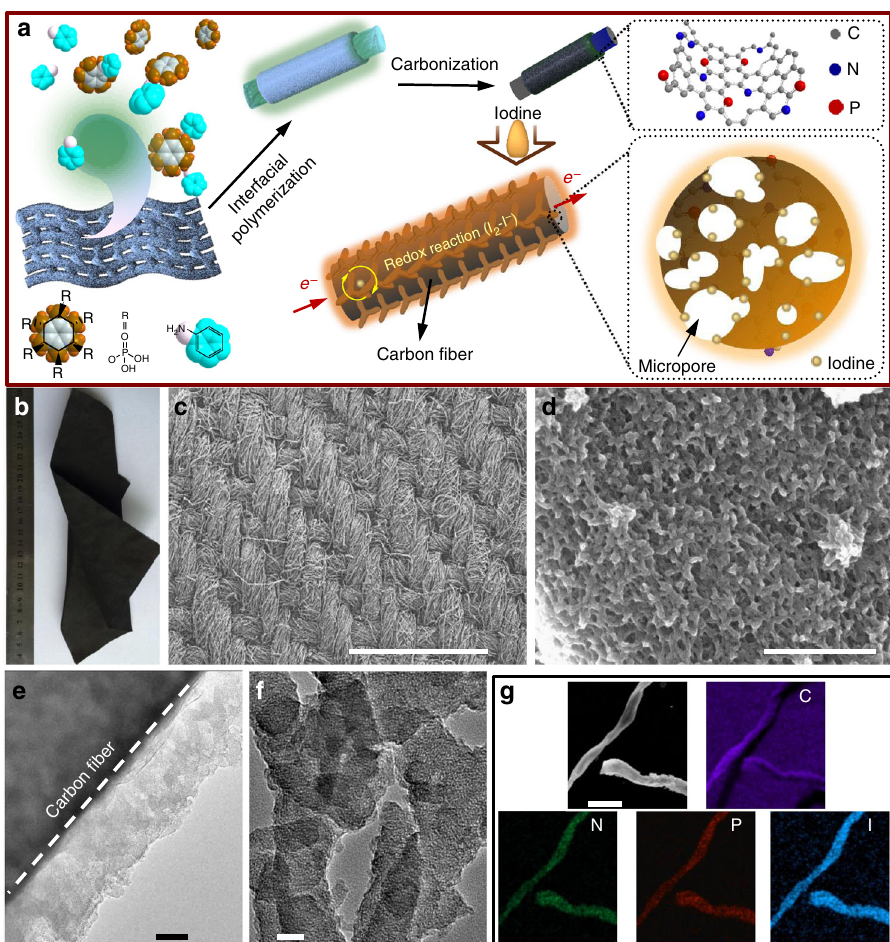
Fig. 1 Preparation of HPMC-NP and the loading iodine. a Interfacial deposition of PANi on the cellulose wiper via an oxidative polymerization in the presence of phytic acid and the subsequent carbonization in N 2 atmosphere. Then, iodine is escasulated into the as-prepared HPMC-NP from the iodine- saturated solution. b The digital photograph, c , d SEM images ( Scale Bar , 1 mm and 500 nm, respectively), and e , f TEM images of the free-standing HPCM-NP ( Scale Bar , 100 nm and 20 nm, respectively). g SEM image ( Scale Bar , 15 μ m) and the corresponding elemental mapping of the iodine loaded